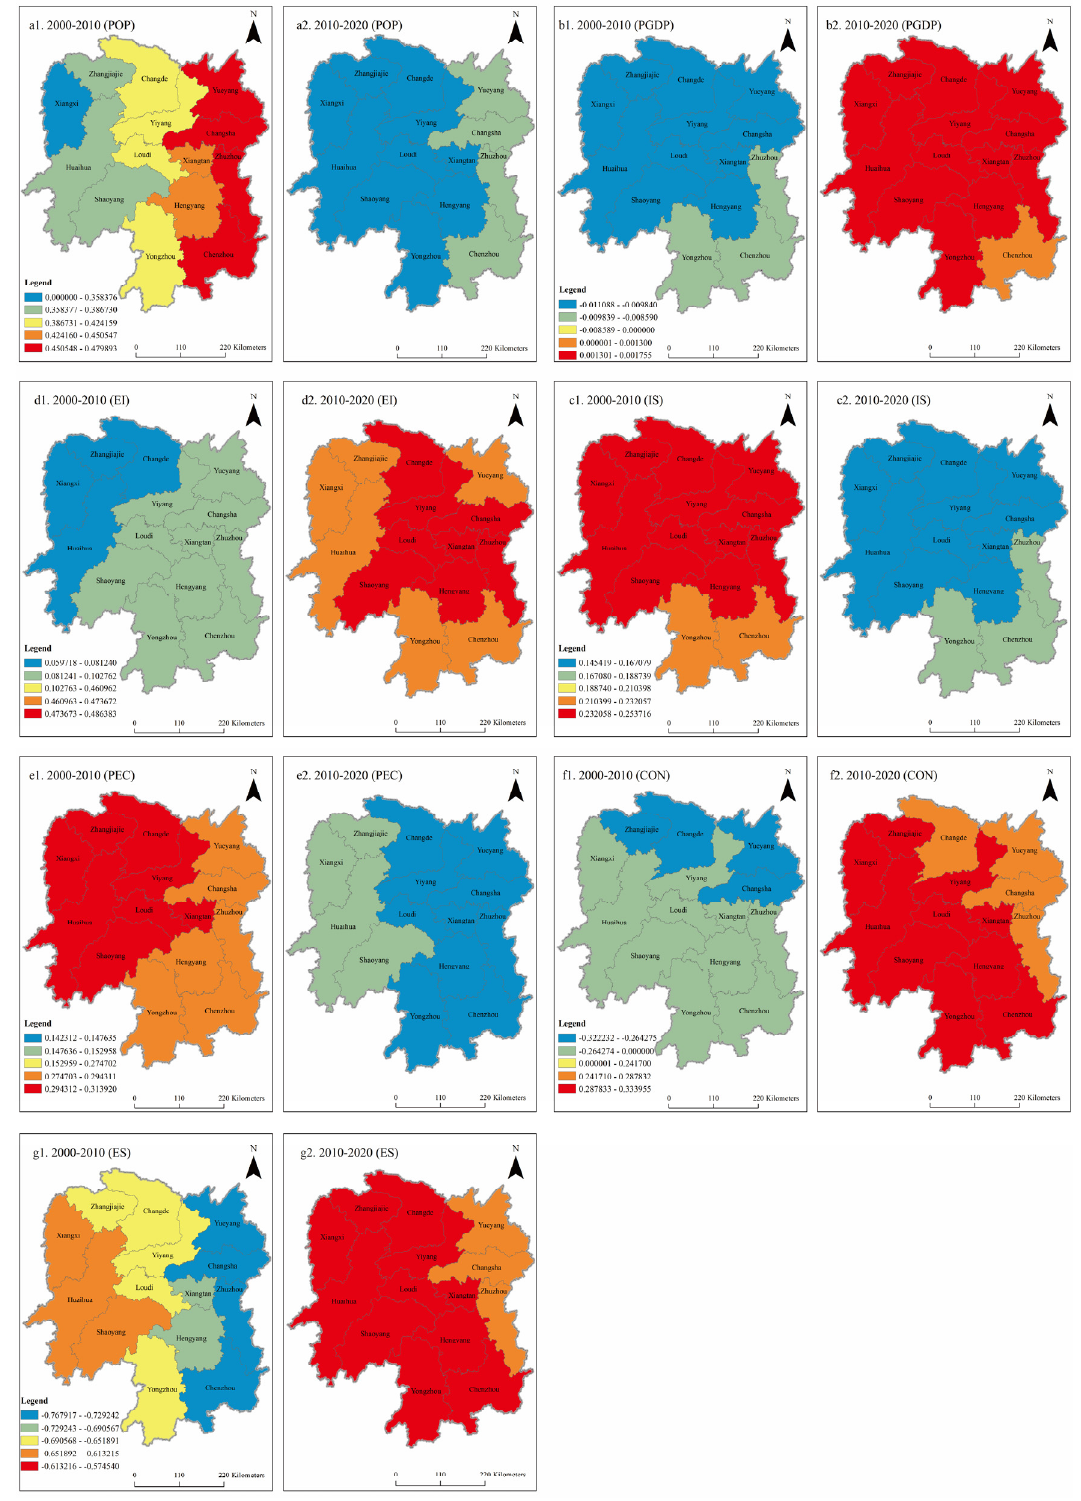
Figure 7. Spatial and temporal distribution of the influence of carbon emission in Hunan Province from 2000 to 2020.